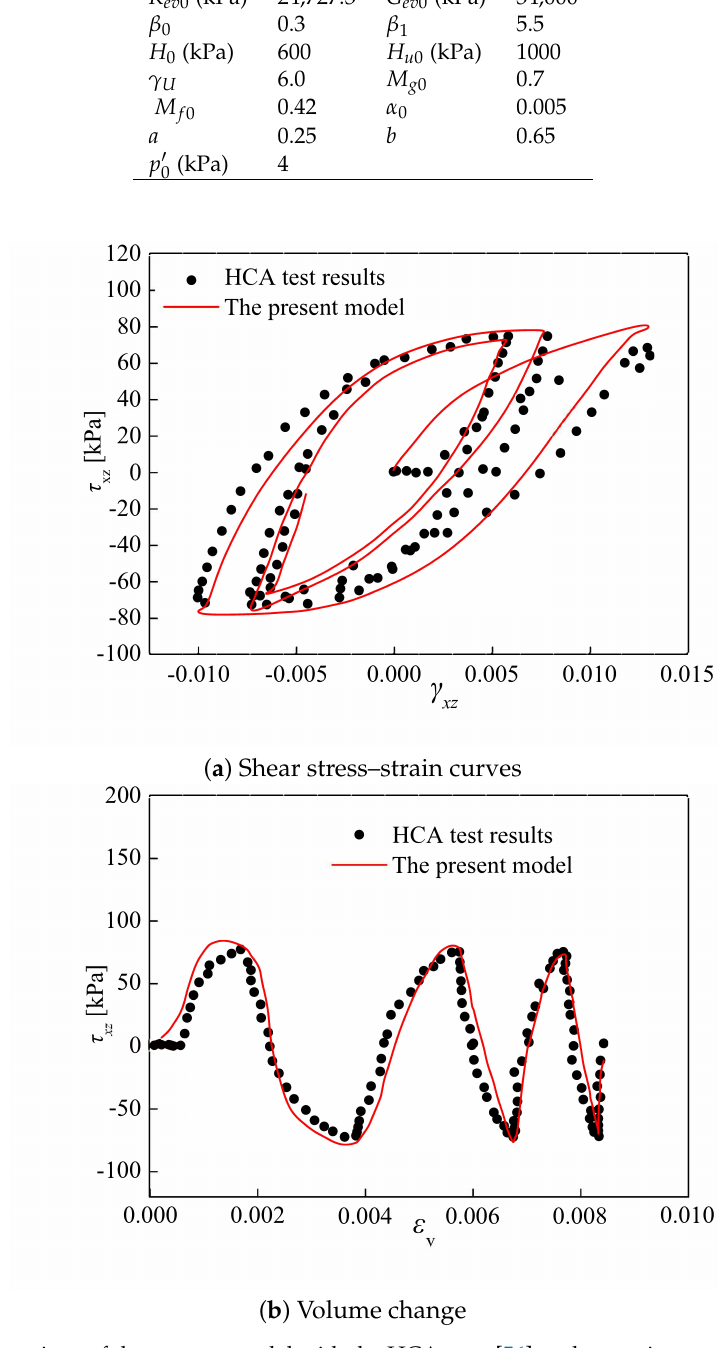
Figure 2. Comparison of the present model with the HCA tests [56] under continuous rotation of the major principal stress